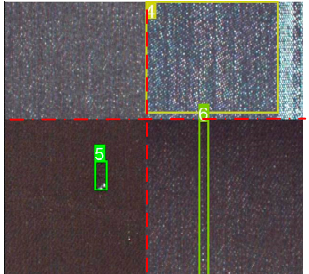
Figure 10. Mosaic data enhancement.